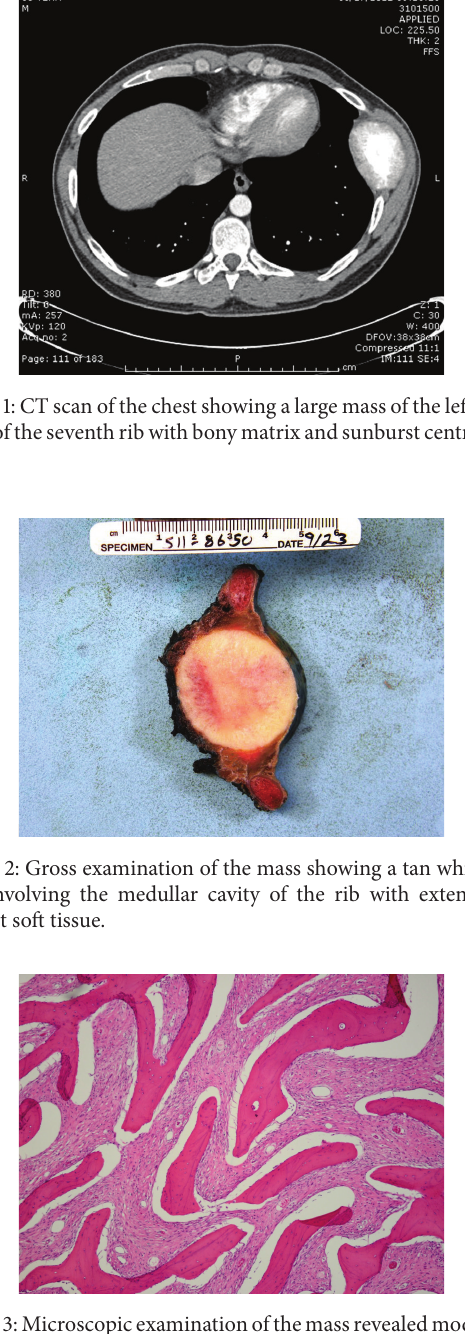
Figure3:Microscopicexaminationofthemassrevealedmoderately atypical fibroblastic cells surrounding parallel trabeculae of woven